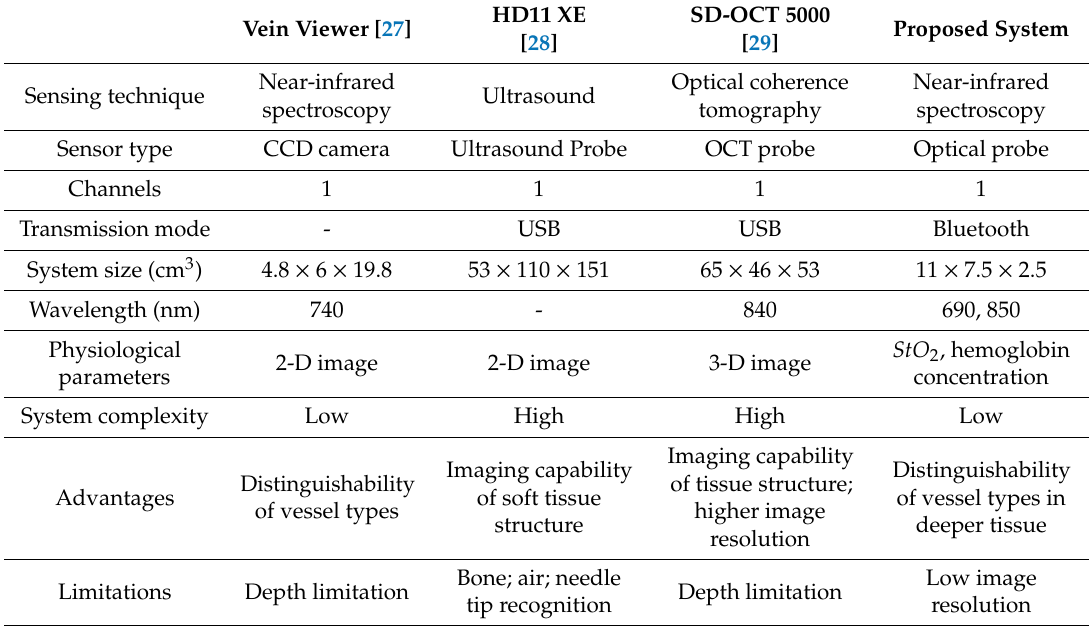
Table 1. System comparison between the proposed system and other